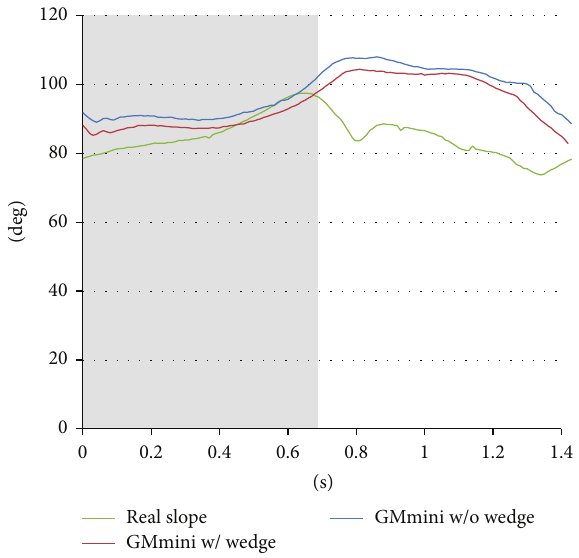
Figure 14: Time series variation of the average angle of the subjects’ ankle during descent of a 5-degree